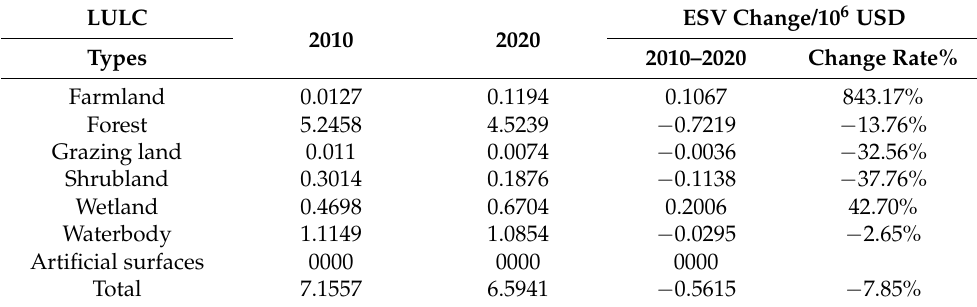
Table 7. Fluctuations in ecosystem service value between 2010 and 2020.